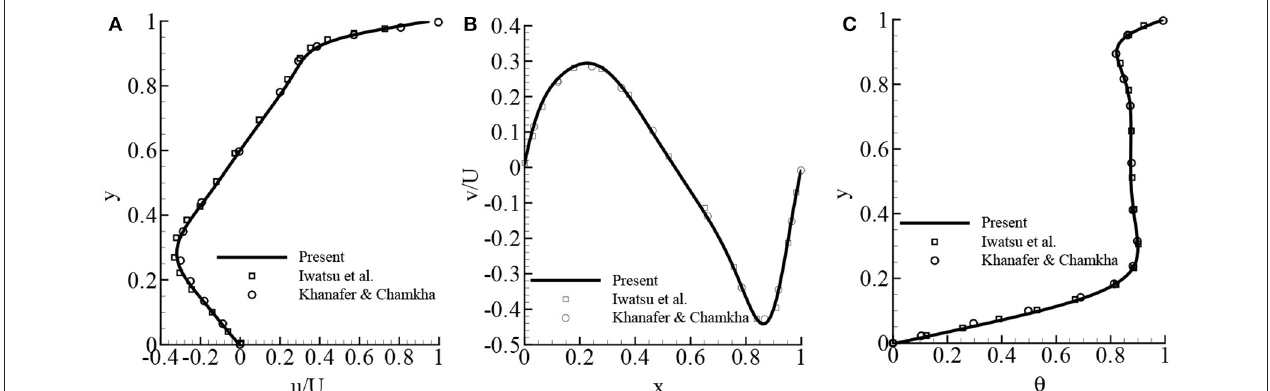
FIGURE 12 | Comparison of the present study’s mixed convection results with the available results of Iwatsu et al. (1993) and Khanafer and Chamkha (1999): (A) u / U velocity, (B) v / U velocity, and (C) temperature θ while Re TABLE 5 | Mixed convection: comparison of the average Nusselt number, Nu , with the available numerical results of Iwatsu et al. (1993), Khanafer and Chamkha (1999); Khanafer et al. (2007), Abdelkhalek (2008), Tiwari and Das (2007), and Kefayati et al. (2012) for Gr